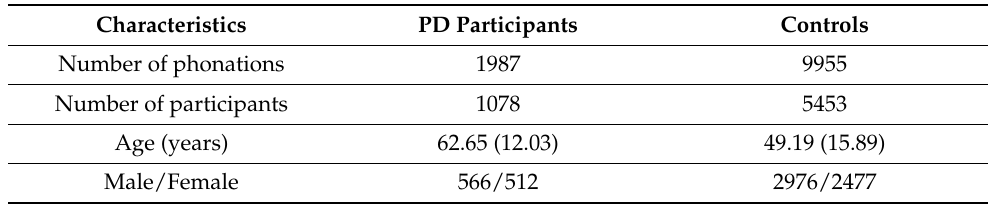
Table 1. Data details and participant